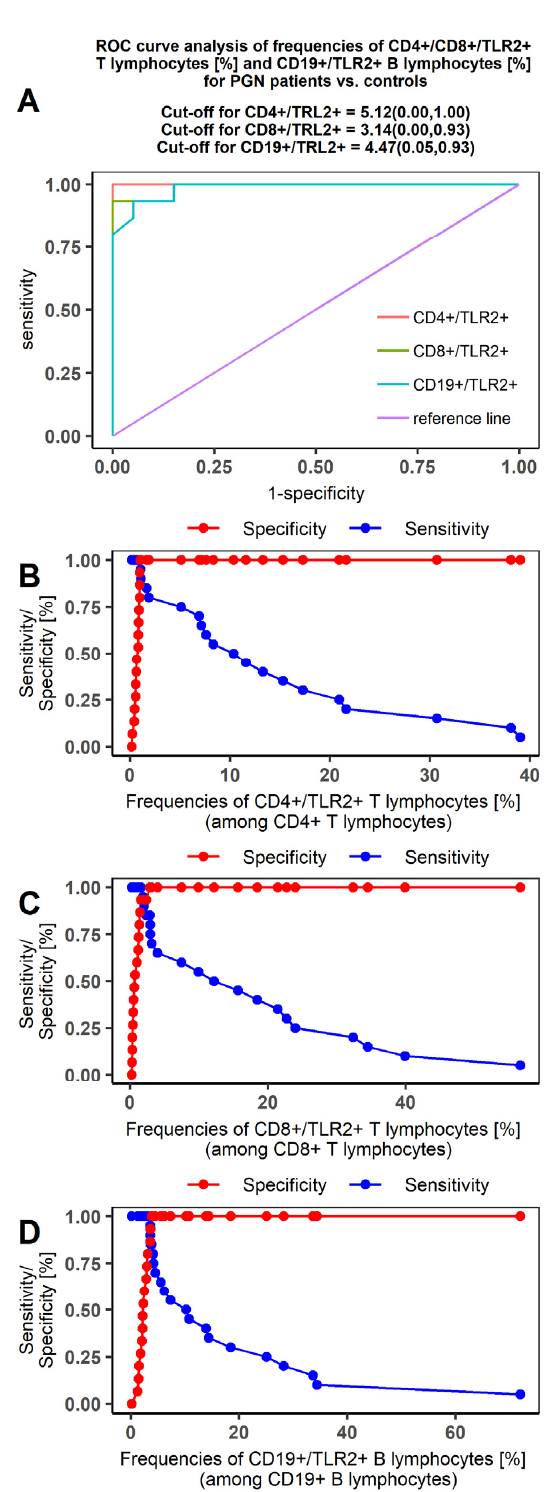
Figure 3. Receiver operating characteristic (ROC) curve analysis on the sensitivity and specificity of TLR2 expression to distinguish between PGN patients and controls. ( A ) ROC curve analysis for CD4+/CD8+/TLR2+ T lymphocyte and CD19+/TLR2+ B lymphocyte frequencies (%) in PGN patients; ( B ) sensitivity/specificity curve for CD4+/TLR2+T lymphocytes (%) in PGN patients; ( C ) sensitivity/specificity curve for CD8+/TLR2+T lymphocytes (%) in PGN patients; ( D ) sensitivity/specificity curve for CD19+/TLR2+B lymphocytes (%) in PGN patients.